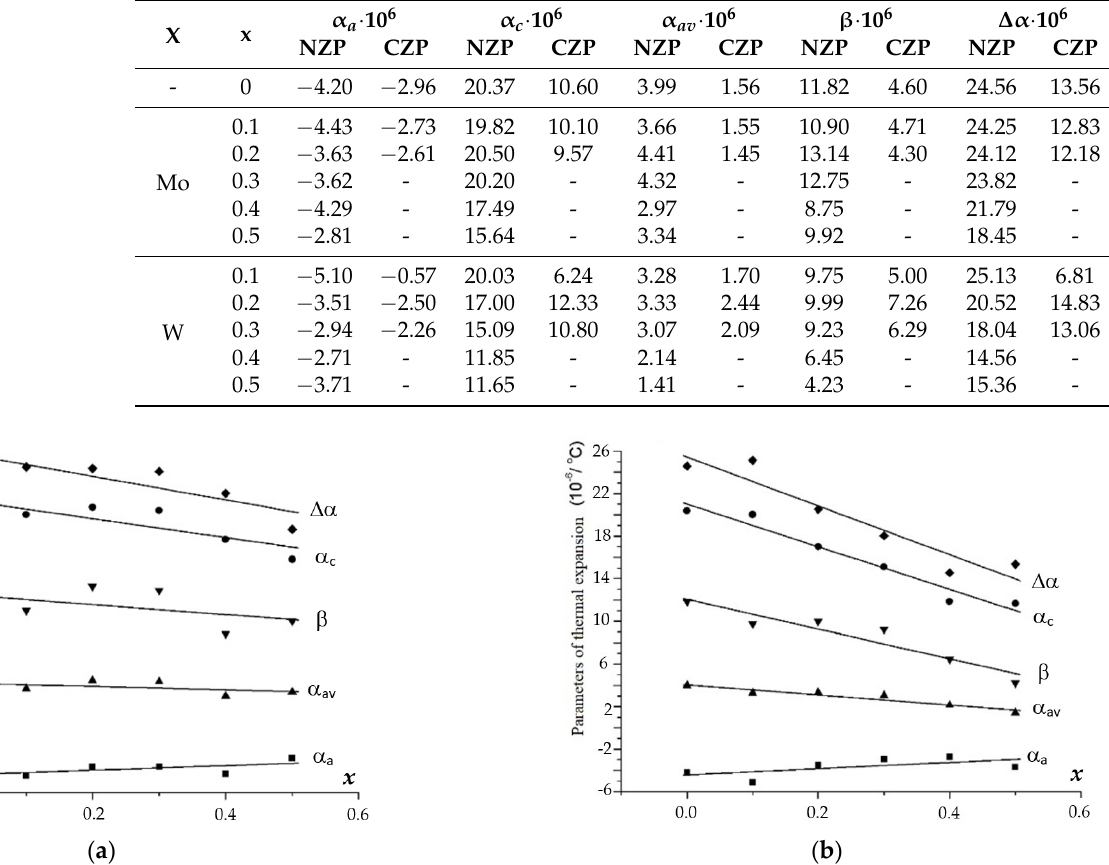
Figure 12. Dependencies of the thermal expansion parameters ( α a , α c , α av , β, and Δα) on the compo-